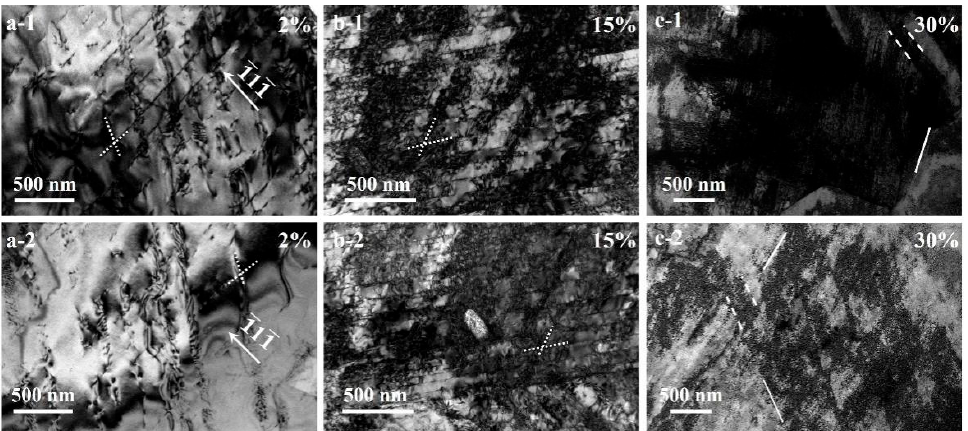
Figure 9. TEM observations for the HS 2 sample showing deformation mechanisms in the coarse grains of austenite phase at varying interrupted tensile strain: ( a-1 , a-2 ) 2%; ( b-1 , b-2 ) 15%; ( c-1 , c-2 ) 30%. Dotted lines: slip traces; solid lines: single-wall DBs; dash lines: microbands.